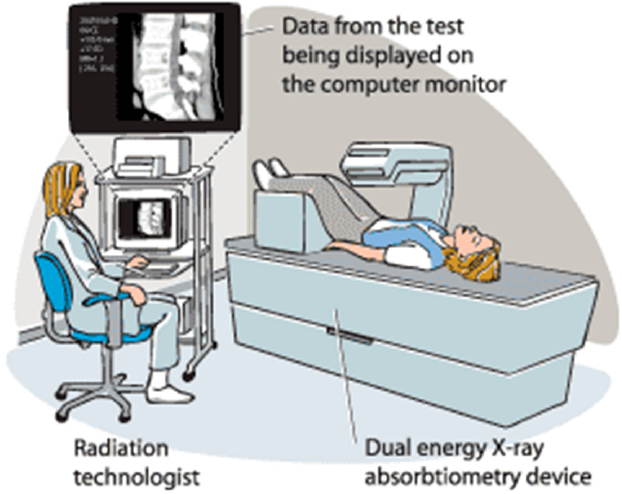
Figure 2. Dual-energy X-ray absorptiometry (DXA) [9].